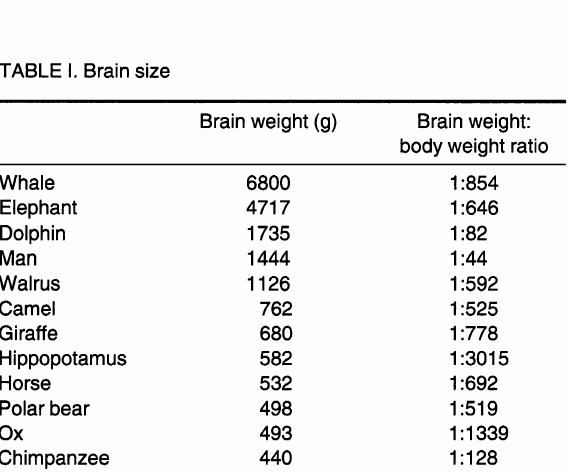
Whale Elephant Dolphin Man Walrus